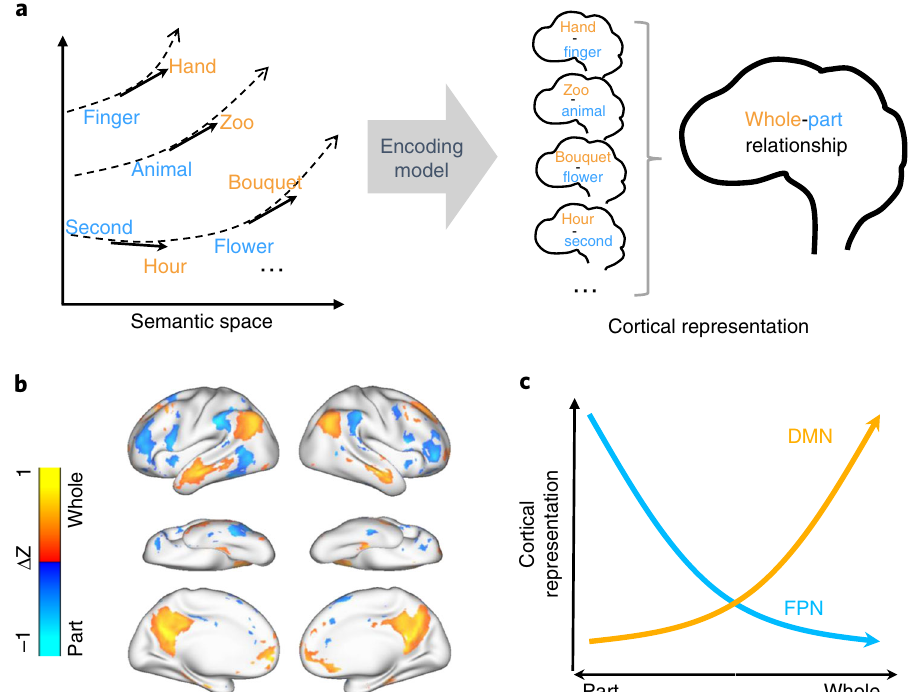
Fig. 6 Mapping cortical representation of the whole-part relation. a The illustration of mapping the whole-part relation from the semantic space to the human brain through the voxel-wise encoding model. We viewed the whole-part relation as a vector fi eld over the semantic space. This relation fi eld was sampled by the difference vector of each word pair that held such a relation (left). The cortical representation of this difference vector was predicted by the voxel-wise encoding model. Cortical representation of the whole-part relation was then obtained by averaging representations of all word pairs (right). b Cortical representation of the whole-part relation. The statistical signi fi cance was assessed by a paired permutation test (178 word pairs, two-sided, FDR q < 0 : 05). c The co-occurring activation of DMN and deactivation of FPN encodes the whole-part relation or the conceptual progression from part to